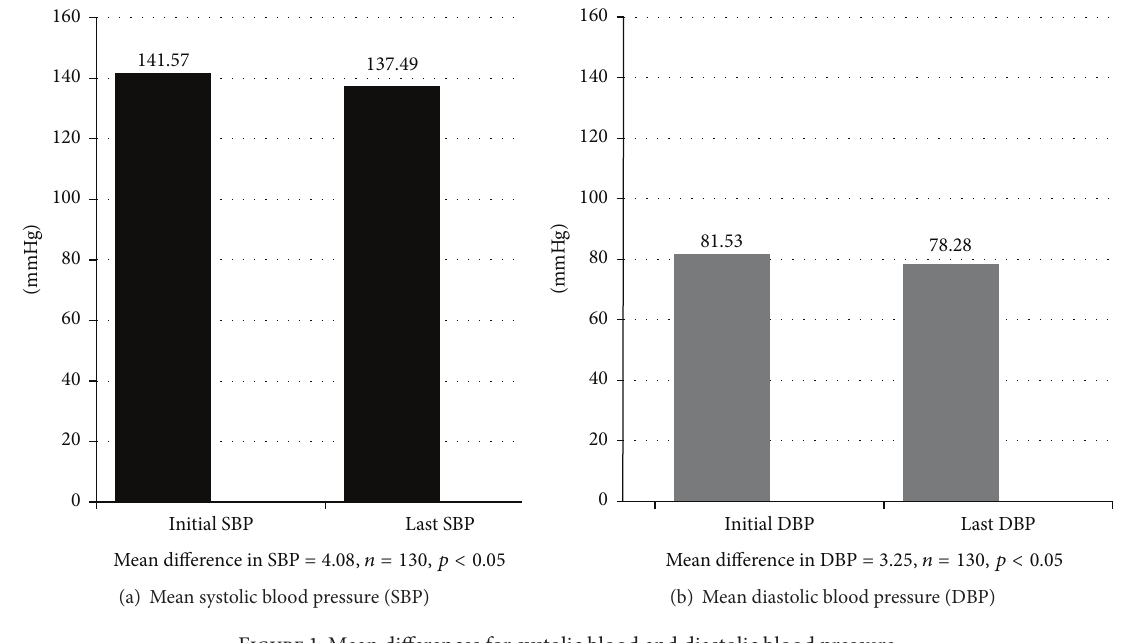
Figure 1: Mean differences for systolic blood and diastolic blood pressure.